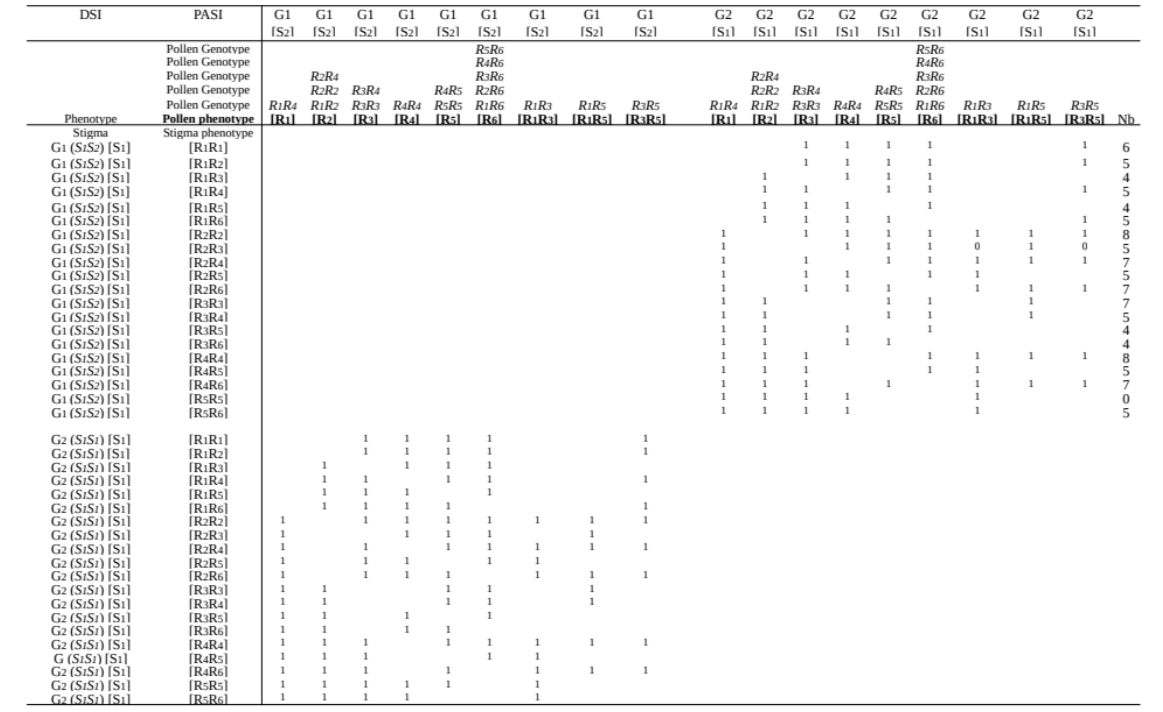
Figure 3. Combination of di ‐ allelic SI (G1 and G2) and poly ‐ allelic SI showing that final fruit success with DSI (1) failed because of PASI (0). Reproduced from Table 1 in Saumitou ‐ Laprade et al. [12] and modified in the frame of DSSM.